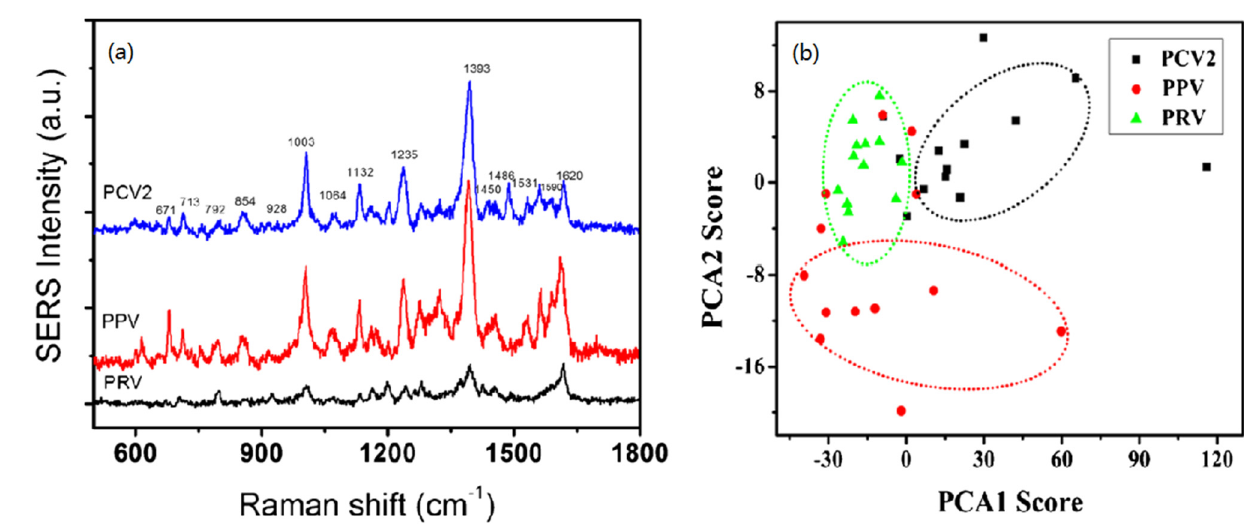
Figure 2. ( a ) SERS spectra of PCV2, PPV and PRV were recorded on the prepared SERS substrate. ( b ) Principal component analysis (PCA) diagram of PC1 and PC2 calculated from SERS spectra of PCV2, PPV and PRV. ( a , b ) Reproduced with permission of Ref. [35] , Copyright 2017, published by Springer Nature.